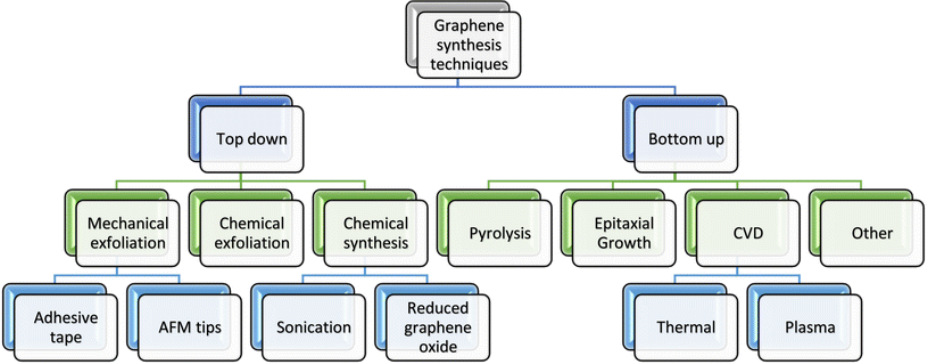
Figure 2. A process of graphene synthesis methods. Reprinted with permission from Ref. [66]. Copyright 2016, Springer Nature.